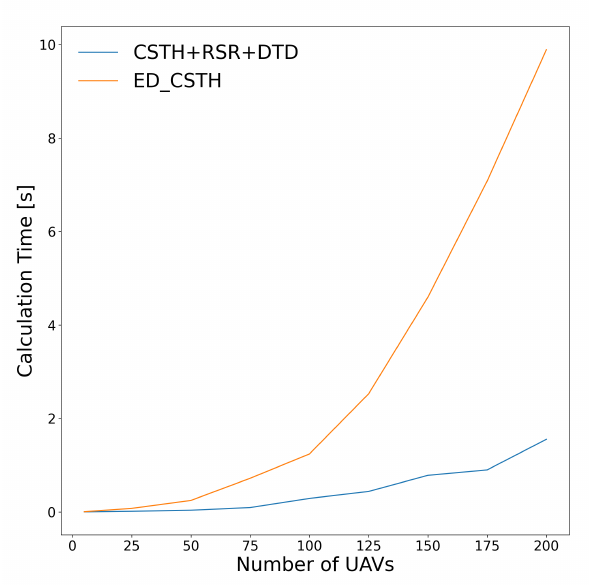
Figure 18. Calculation time in circular